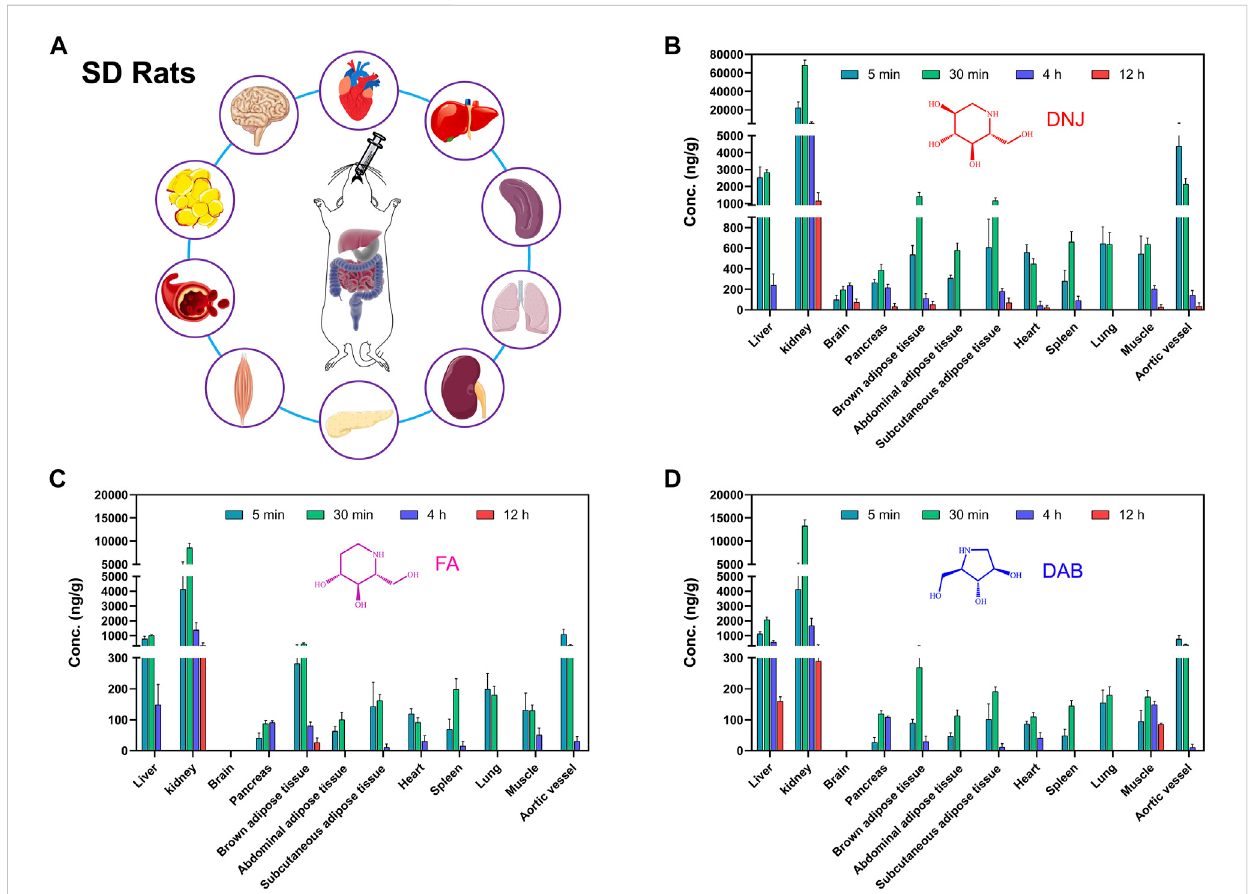
FIGURE 4 Experimental scheme of tissue concentration determination after oral administration of SZ-A in rats (A) . The concentration of the three active components of SZ-A, including DNJ (B) , FA (C) , and DAB (D) , in tissues, including heart, liver, spleen, lung, kidney, aortic blood vessel, brown adipose tissue, subcutaneous adipose tissue, abdominal adipose tissue, muscle, pancreas, and brain, after a single oral administration of SZ-A (40 mg/kg) in SD rats. Each value represents the mean ± standard error of mean (SEM) ( n =